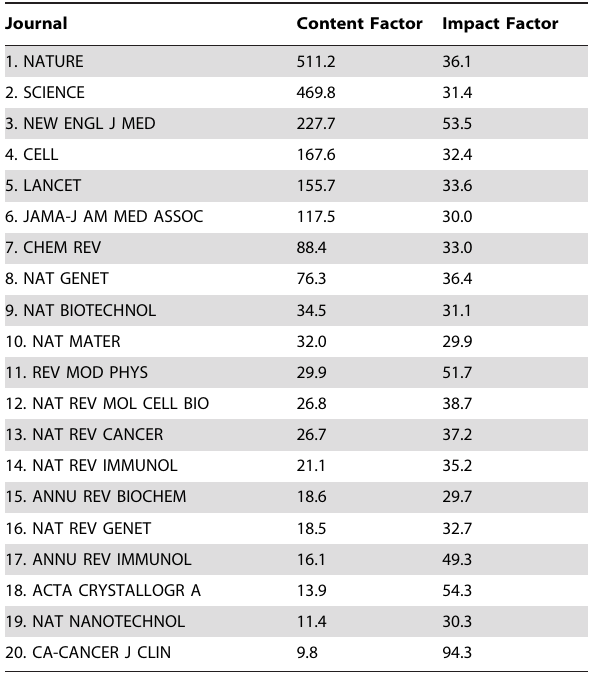
Table 1. Content and Impact Factors for the twenty biomedical journals with highest Impact Factors, 2010, listed in order of highest Content Factor.